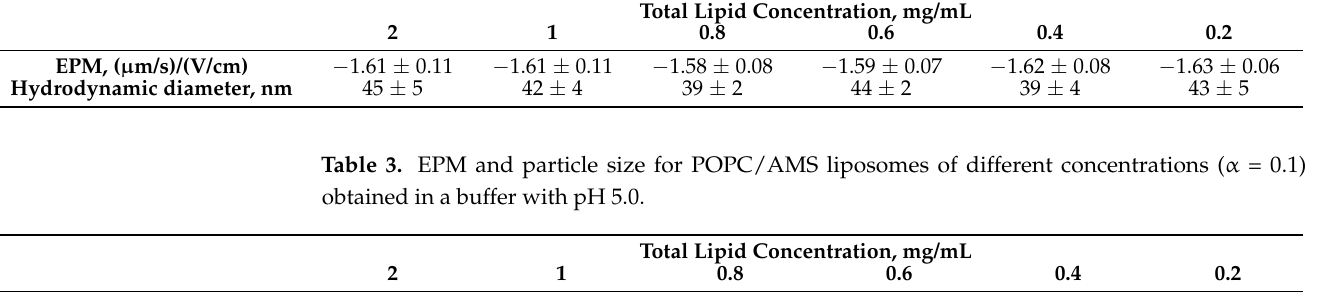
Table 3. EPM and particle size for POPC/AMS liposomes of different concentrations (α = 0.1) ob- tained in a buffer with pH 5.0.